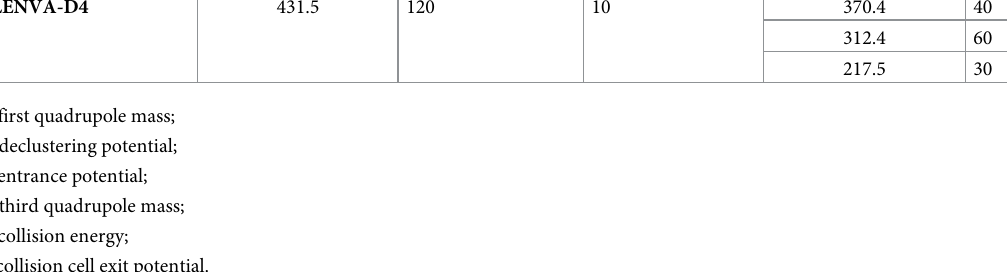
Table 2. Optimized compound-dependent parameters of LENVA and LENVA-D 4 (IS).